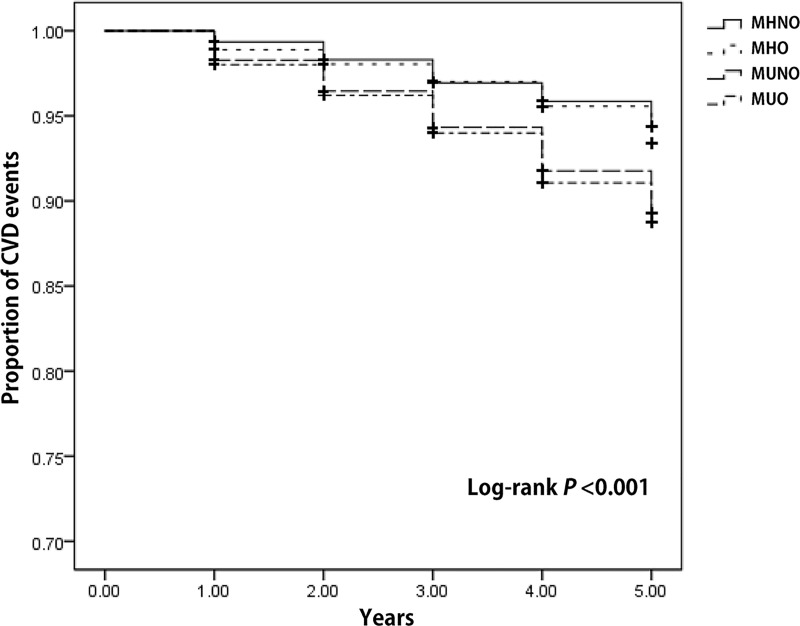
Kaplan–Meier curves of CVD events according to metabolic health and obesity status.During ten-year follow-up periods, the metabolically healthy group shows better event-free survival than the metabolic unhealthy group regardless of obesity.